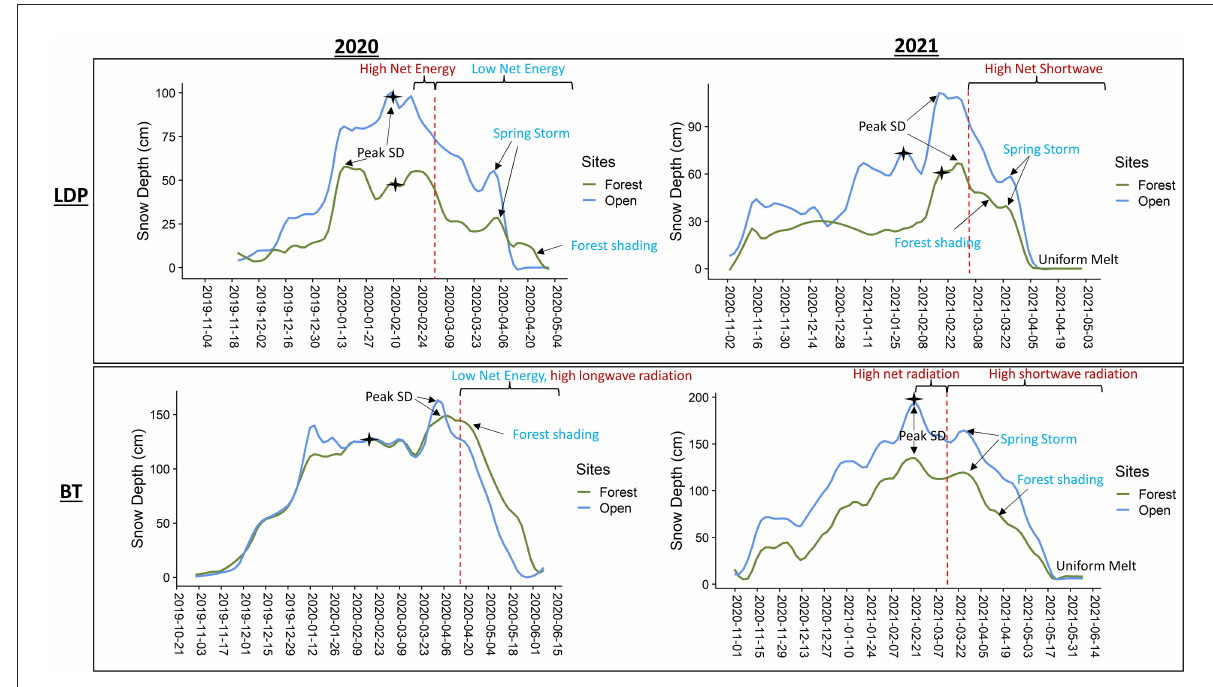
FIGURE10 Annotated, loess-smoothed snow depth at the forest and open sites at both study locations and years. The red dotted line represents the start of snowmelt infiltrating the soil profile. The black stars are the timing of the peak E cc during the snow pit data collection periods. Variables that slow the snowmelt rate and lead to later snow disappearance are in blue while variables that increase the snowmelt rate and lead to earlier snow disappearance are in red. Net energy is the net energy flux defined in Equation